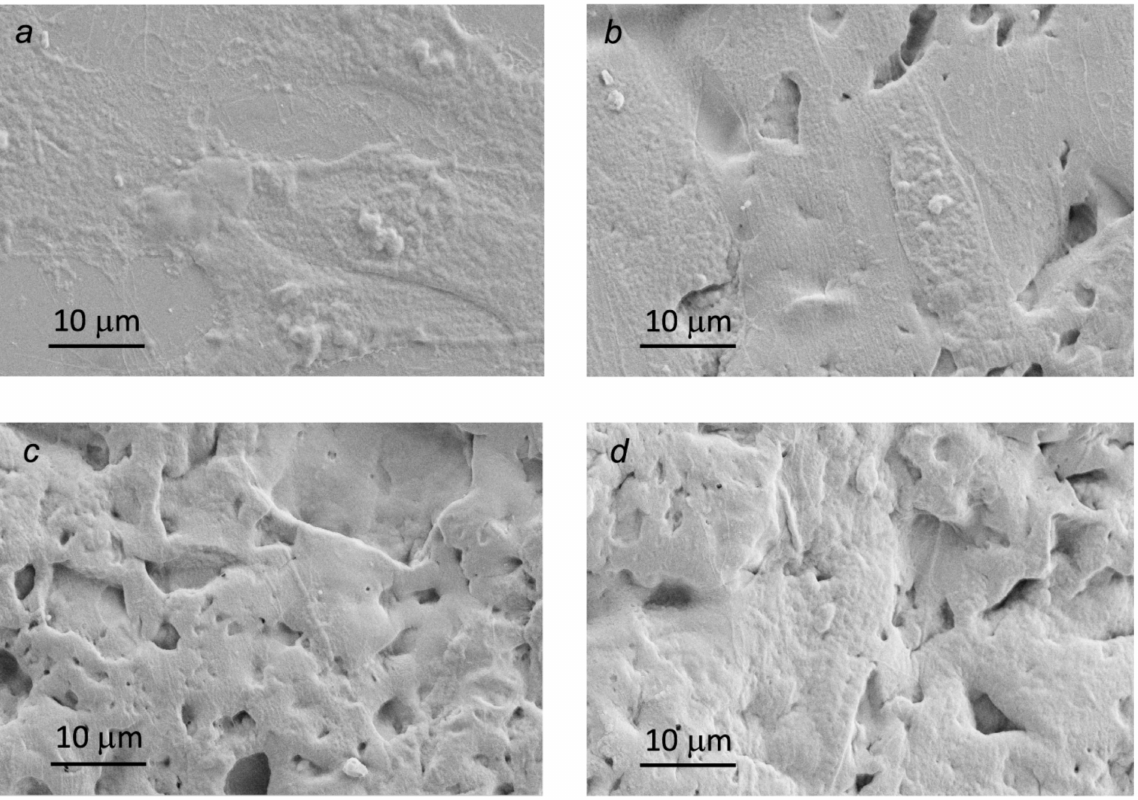
Figure 7. SEM images of human dermal fibroblasts grown of the surface of pure chitosan matrix ( a ) and composite matrix containing 10% of lignin ( b ), ( c ) 20% of lignin, and ( d ) 30% of lignin after 4 days of